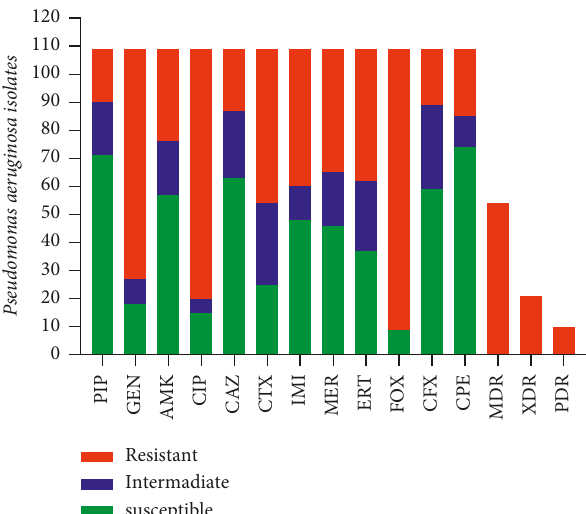
Figure 1: Antibiotic resistance pattern in clinical isolates of P. aeruginosa . PIP: piperacillin; GEN: gentamycin; AMK: amikacin; CIP: ciprofloxacin; CAZ: ceftazidime; CTX: ceftriaxone; IMI: imipenem; MER: meropenem; ERT: ertapenem; FOX: cefoxitin; CFX: cefazolin; CPE: cefepime; MDR: multiple drug resistance; XDR: extensively drug-resistant; PDR: pan Table 3: Correlation between OXA genes, biofilm formation, separated clinical isolates, and antibiotic resistance in P. aeruginosa . Biofilm